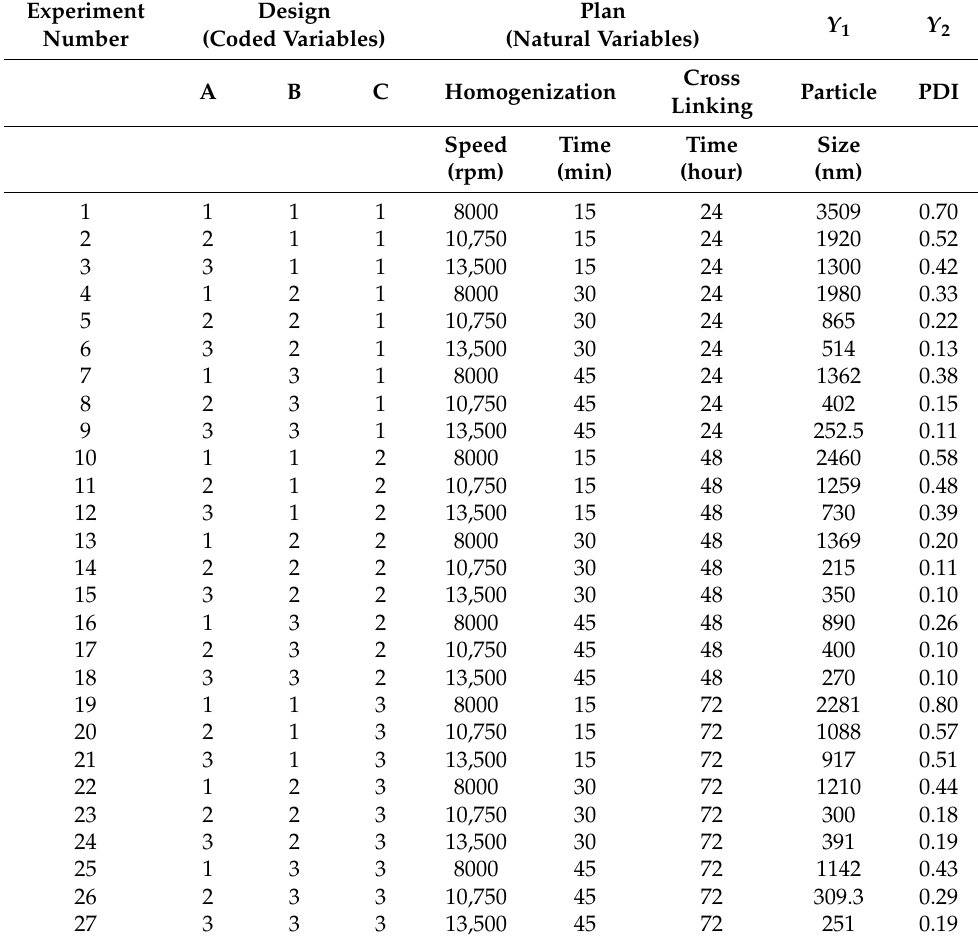
Table 2. Experimental 3 3 factorial design for nanocapsules (NanoC) preparation and the response variables under